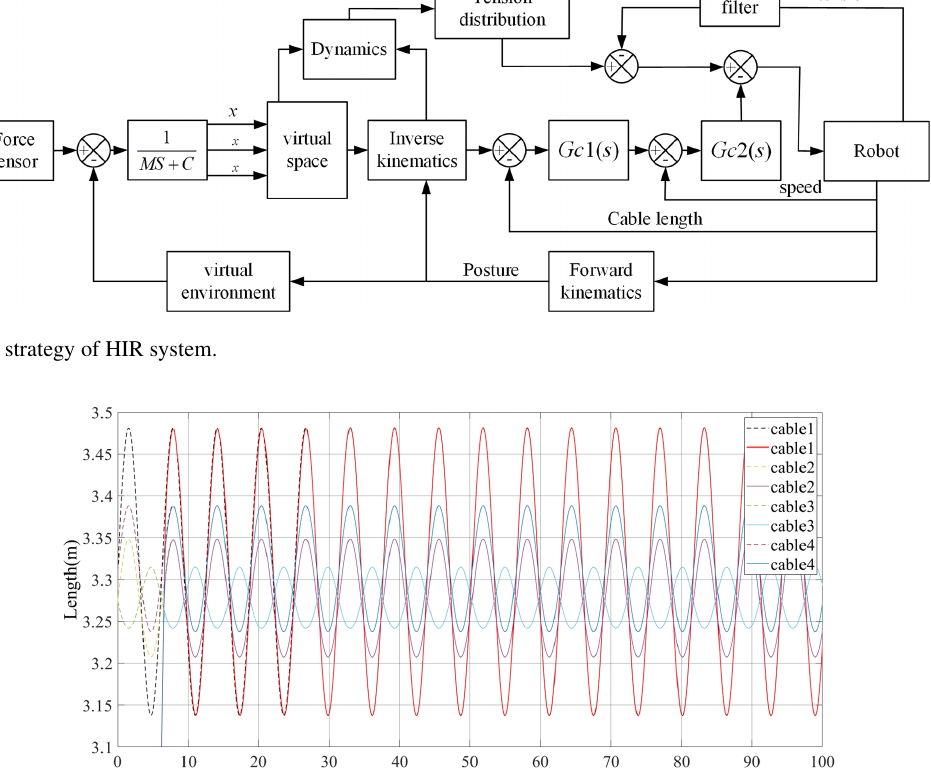
ignored, the open-loop Bode diagram of the system after cor- recting the proposed position and PID controllers is shown in Fig. 17a. The turning frequency of the proposed position con- troller exceeds that of the PID controller and is considerably stable. The input is the typical sine signal, S = 100sin( t